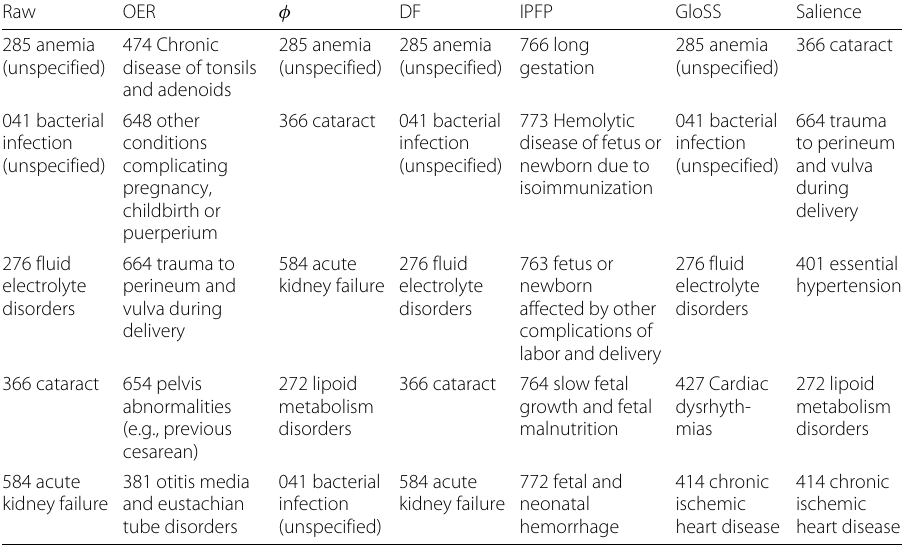
Table 4 Top 5 diseases with highest in-strength in different networks Raw